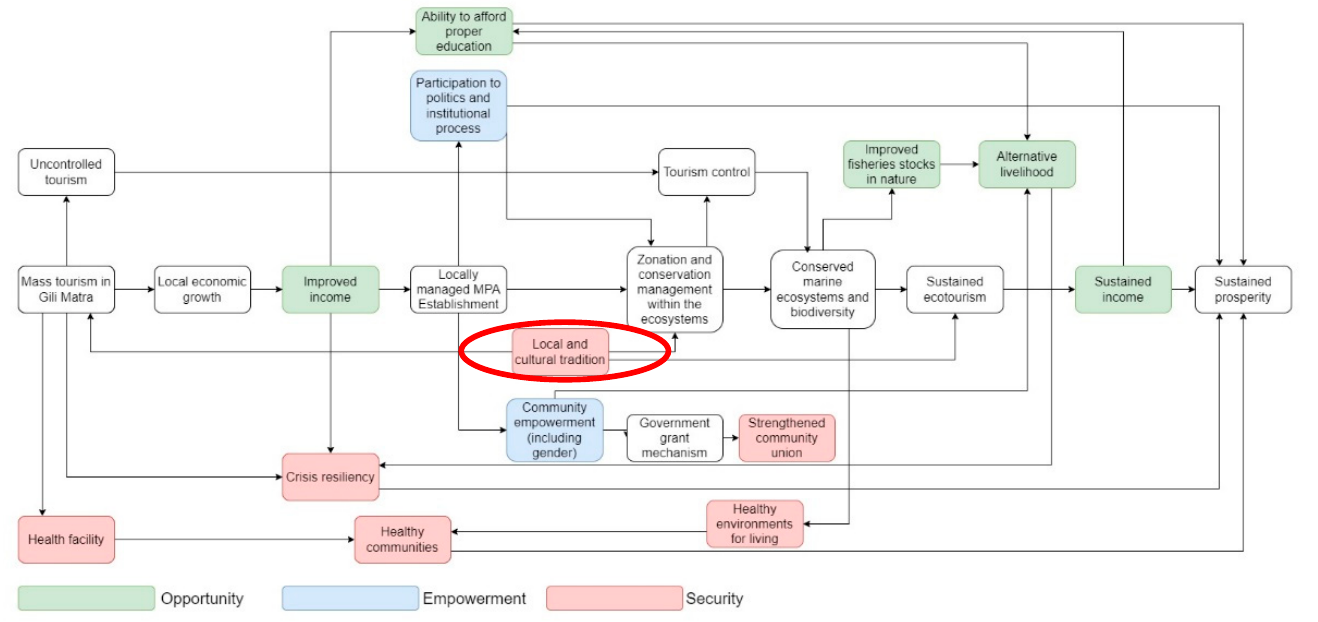
Figure 5. Mental model of non-influential stakeholders in the Gili Matra MPA regarding the MPA’s influence on prosperity. Each box represents a situation in Gili Matra that is related to the prosperity and MPA management in Gili Matra. The colored boxes indicate their categorization to the World Bank domains of prosperity (opportunity, empowerment, security), while the transparent boxes indicate no inclusion with the mentioned domains. The aforementioned stakeholders have a similar way of thinking compared to the influential stakeholders, with the exception of the management delivery, where the local management approach is believed to have a greater impact (red oval).